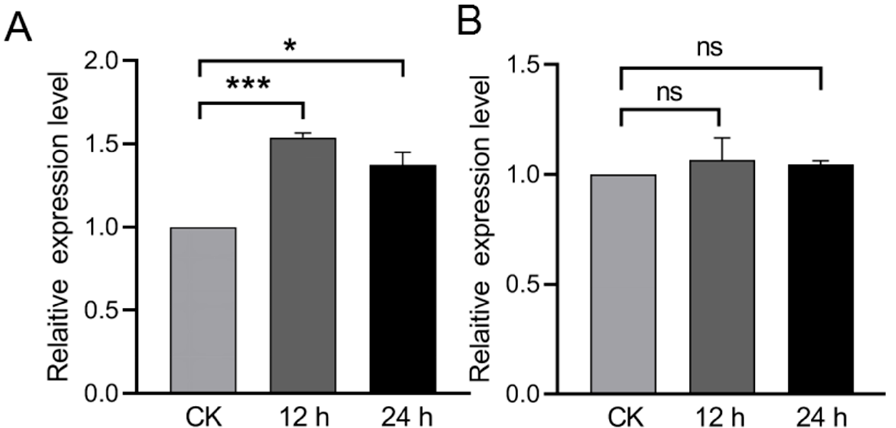
Figure 3. Expression profiles of prophenoloxidase genes in Bemisia tabaci after feeding on ToCV ‐ infected tomatoes for different durations. ( A ) BtPPO1 and ( B ) BtPPO2 . Data are presented as the mean ± SE for four independent replicates. The data were normalized to the expression of SDHA and EF ‐ 1 α . Asterisks indicate significant differences between the treatment and corresponding un ‐ treated control according to the Student’s t ‐ test . * p < 0.05, *** p < 0.001, ns indicates no significant difference.